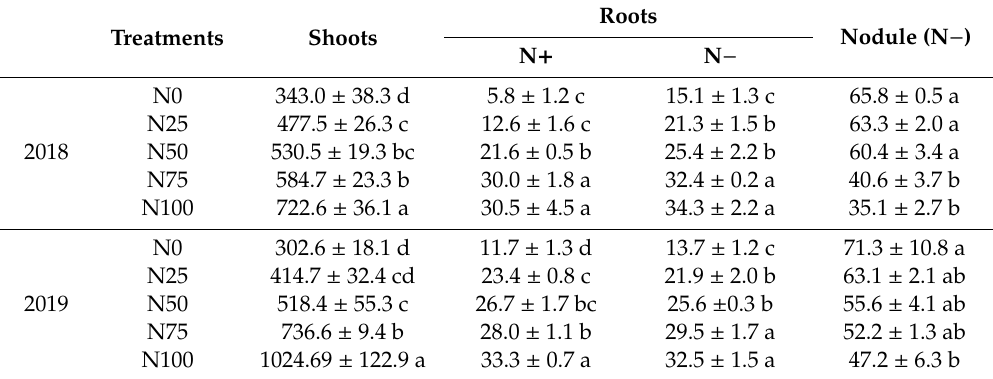
Table 6. Nitrogen accumulation at the V3-R3 stages of experiment I (mg /